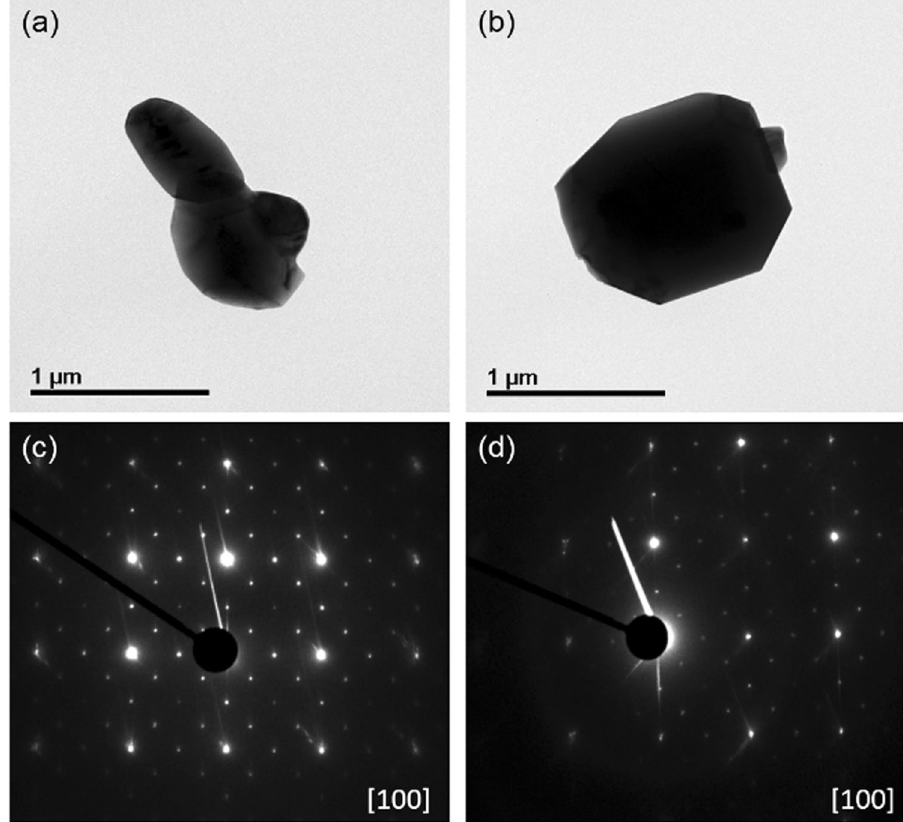
Figure 2. TEM images of ( a ) bare − 700 °C sample ( b ) Li-doped − 700 °C sample. Selected area electron